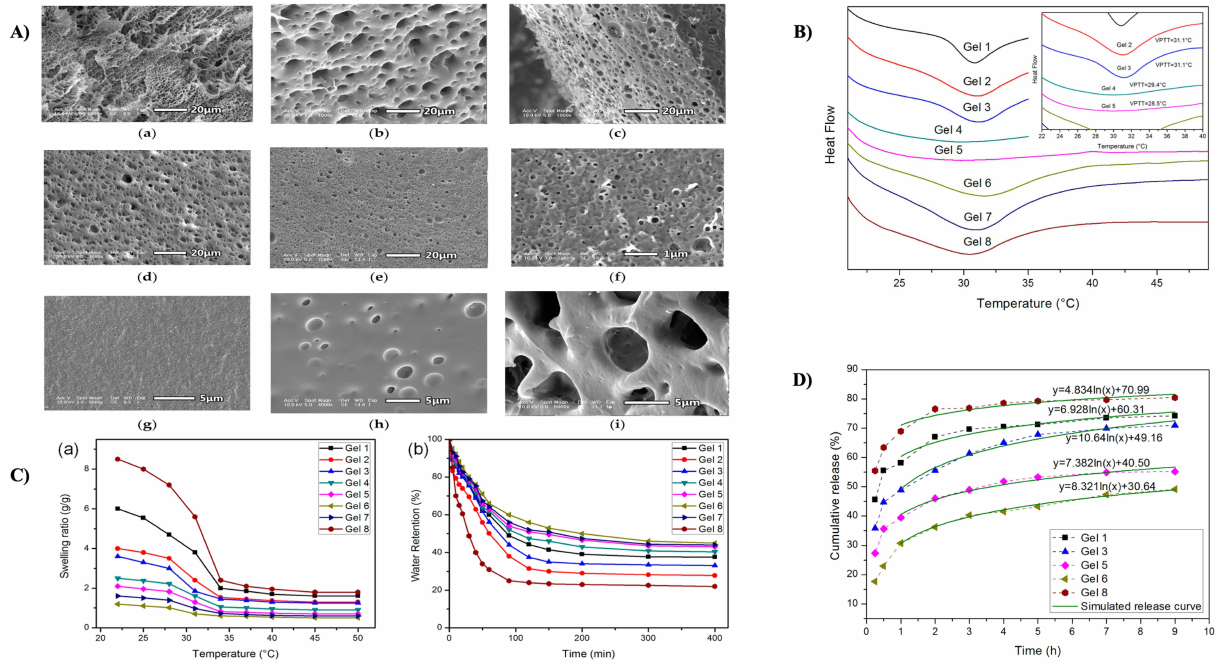
Figure 2. ( A ) SEM images of (a) Gel 1; (b) Gel 2; (c) Gel 3; (d) Gel 4; (e) Gel 5; (f,g) Gel 6; (h) Gel 7; and (i) Gel 8. ( B ) DSC analysis of gel phase transition characteristics. ( C ) (a) Temperature-dependent swelling ratios of gels between 20 and 50 degrees Celsius; (b) gel deswelling behavior at 60 degrees Celsius. ( D ) The simulated release curves and release behaviors of 5-FU from gels in PBS (pH 7.4) at 37 ◦ C